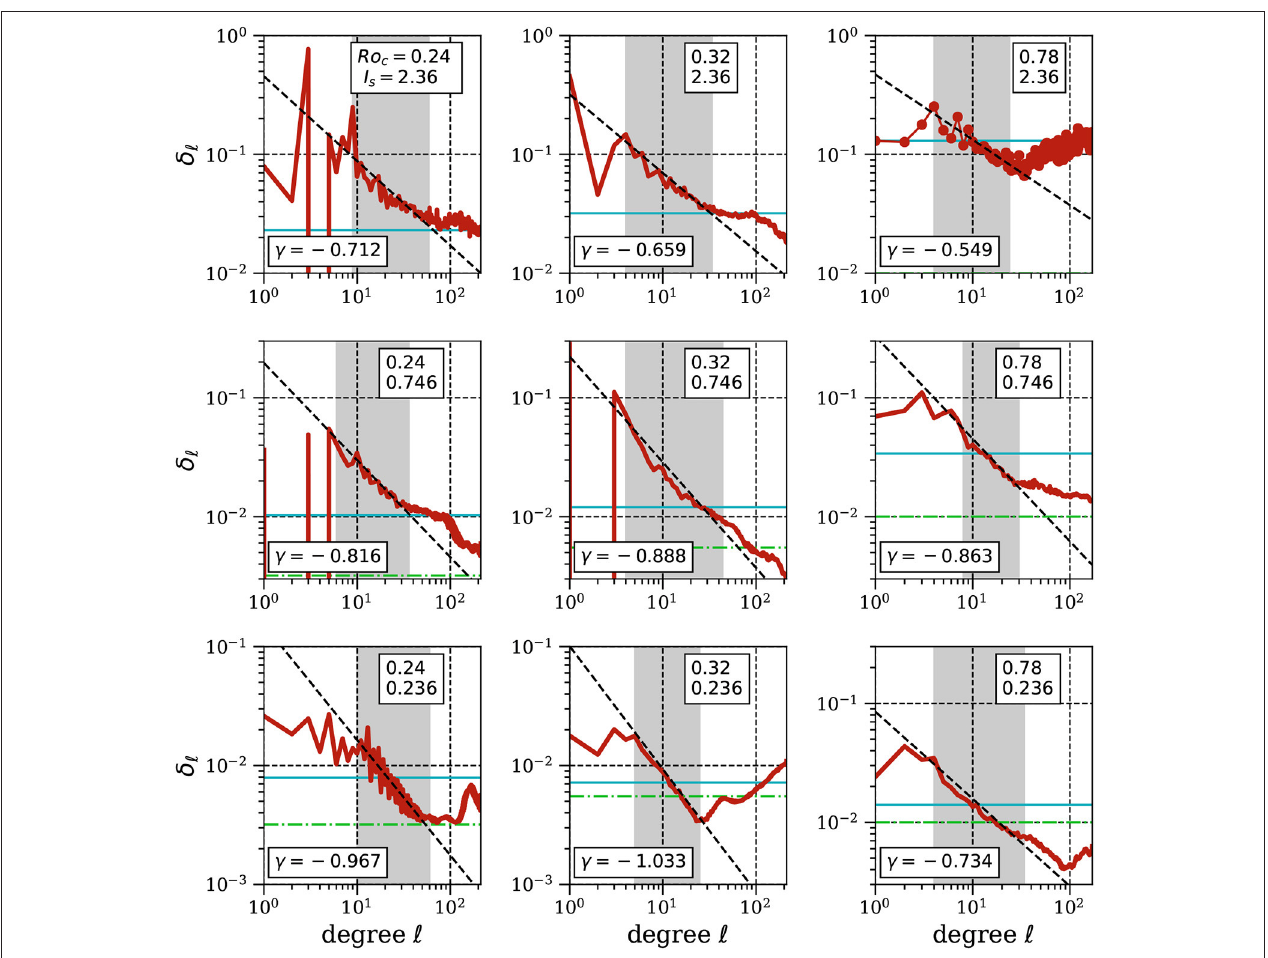
FIGURE 8 | Penetration depth as a function of spectral degree ℓ for the nine case of group 4 in Table 1 . The horizontal blue lines indicate the mean values. The green √ E . The black lines show power laws fitted over the gray-shaded length scale ranges resulting into a decay line shows the thickness of an Ekman layer δ ν = exponent γ added at the bottom of each figure.